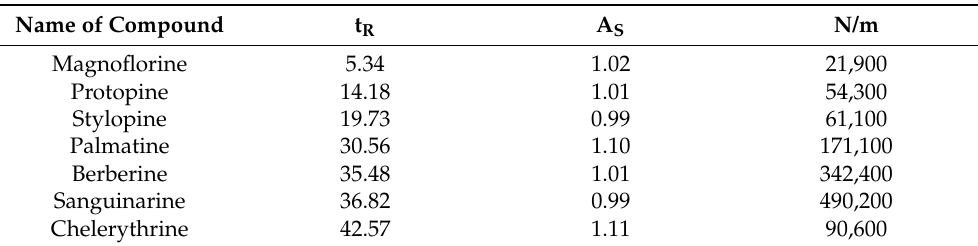
Figure 1. HPLC-DAD chromatogram obtained for mixture of alkaloid standards: 1—magno fl orine, 2—protopine, 3—stylopine, 4—palmatine, 5—berberine, 6—sanguinarine, 7—chelerythrine. Table 1. Values of retention time (t R ), asymmetry factor (A S ), and theoretical plate number per meter (N/m) obtained for alkaloid standards.